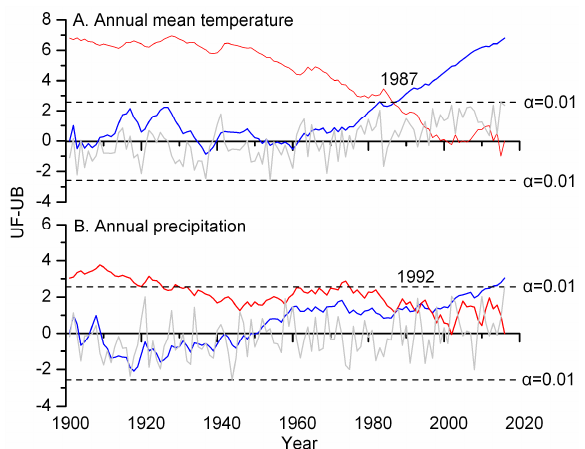
Figure 3. Results of Mann–Kendall tests for ( A ) annual mean temperature and ( B ) annual precipitation (1901–2016).